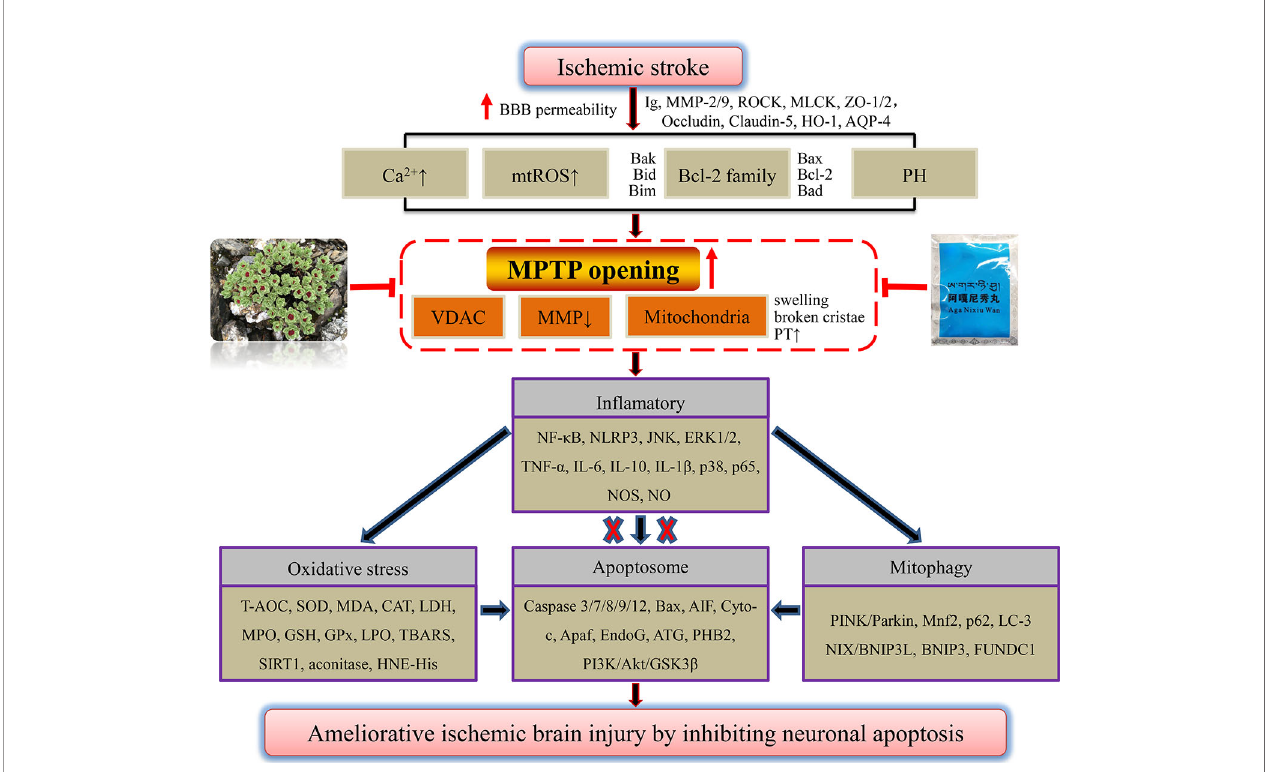
FIGURE 4 | A panoramic view of natural products inhibiting MPTP opening-induced neuronal apoptosis in the treatment of ischemic stroke. Any adverse stimuli after ischemic stroke could favor MPTP opening. However, natural products that inhibit MPTP opening could further prevent neuronal in fl ammation after ischemia, oxidative stress injury, and mitophagy, and fi nally repress ischemic neuron